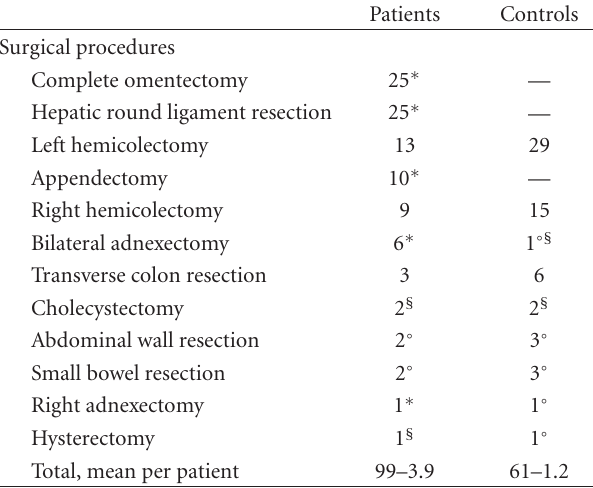
Table 2: Surgical procedures performed in the 2 groups.